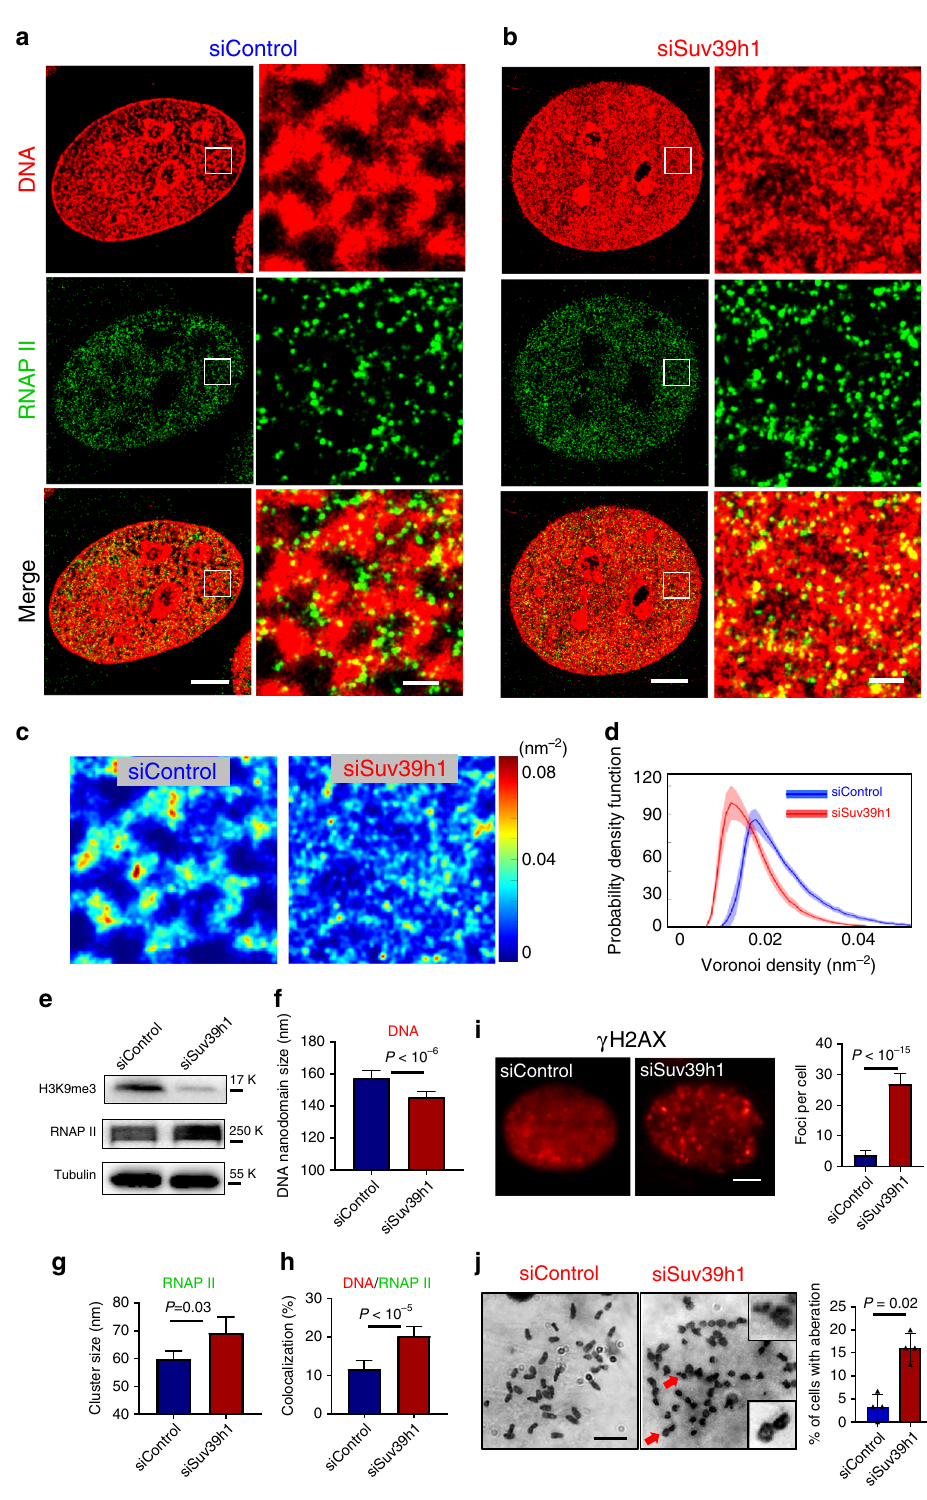
Methods Immuno fl uorescence staining of tissue samples . All animal studies were per- formed in accordance with the institutional Animal Care and Use Committee at the University of Pittsburgh. All mice were housed in micro isolator cages in a temperature- (68 – 79°F) and humidity (30 – 70% relatively humidity)-controlled room illuminated from 7:00 a.m. to 7:00 p.m. (12h:12h light – dark cycle), with access to water and chow ad libitum. The use of tissue blocks from deidenti fi ed patients was approved by the Institutional Review Board at University